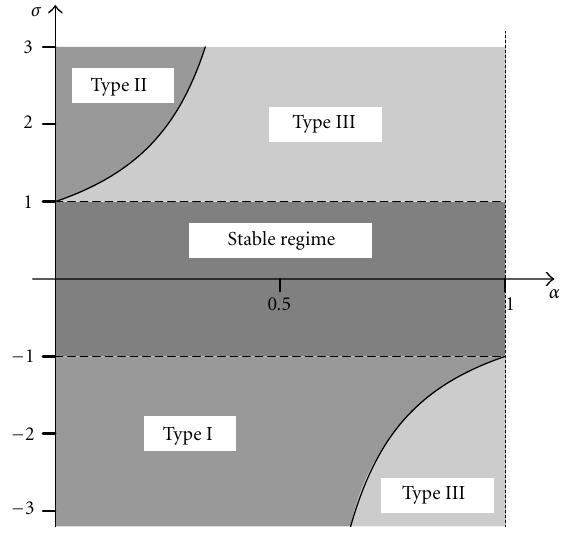
Figure 3.1. Distribution of the generic steady state.